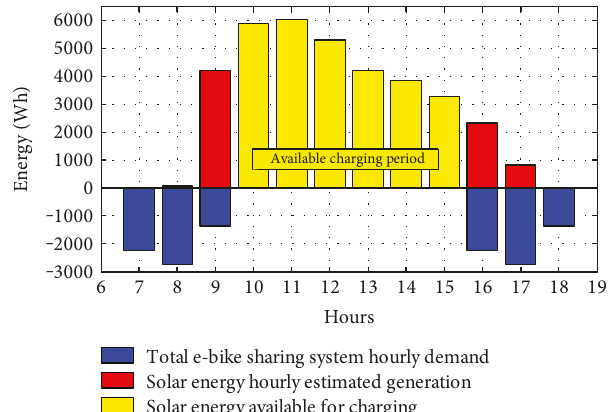
Figure 11: Total e-bike sharing system energy demand versus solar energy available for charging.